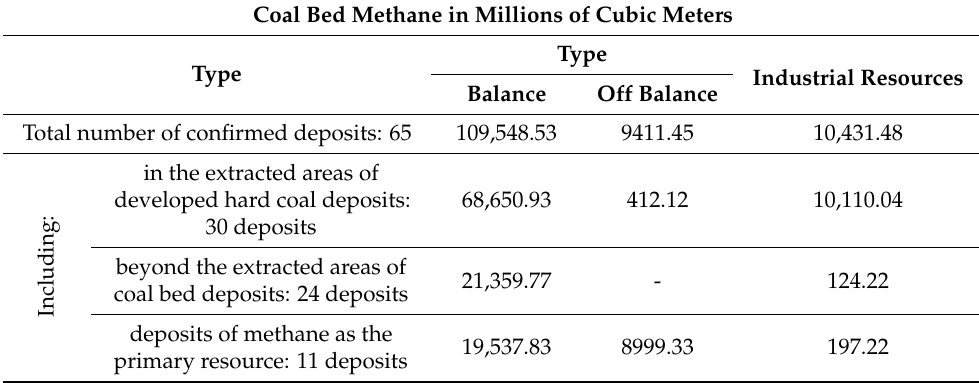
Table 1. State of methane resources in Polish coal beds as of 31 December 2019 (following